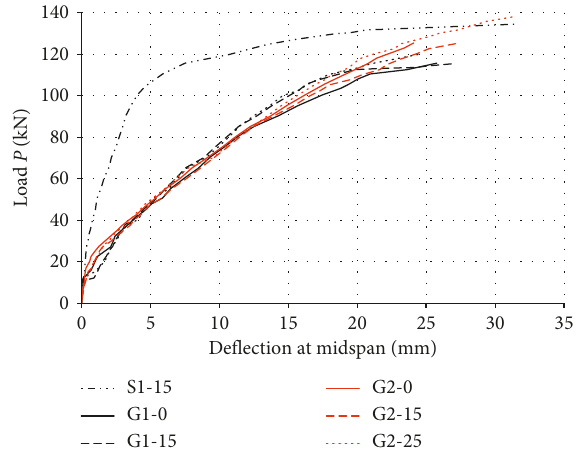
Figure 8: Load-deflection relationship at the midspan for tested